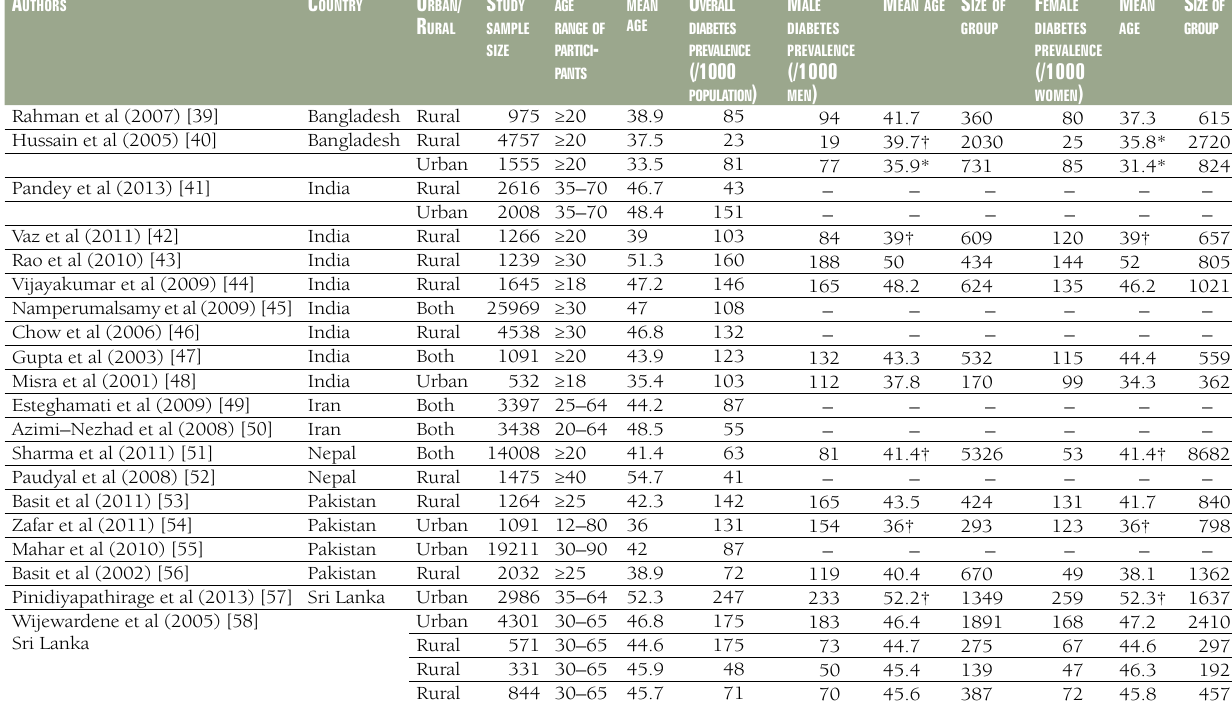
Table 9. Individual study prevalence data: FPG–only studies a uthorS C ountry